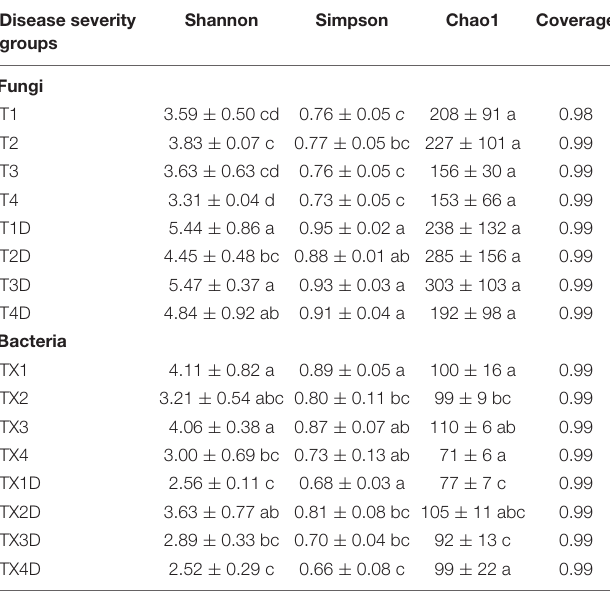
TABLE 2 | Alpha-diversity indexes of fungal and bacterial community based on high-throughput sequencing in different samples. Disease severity groups